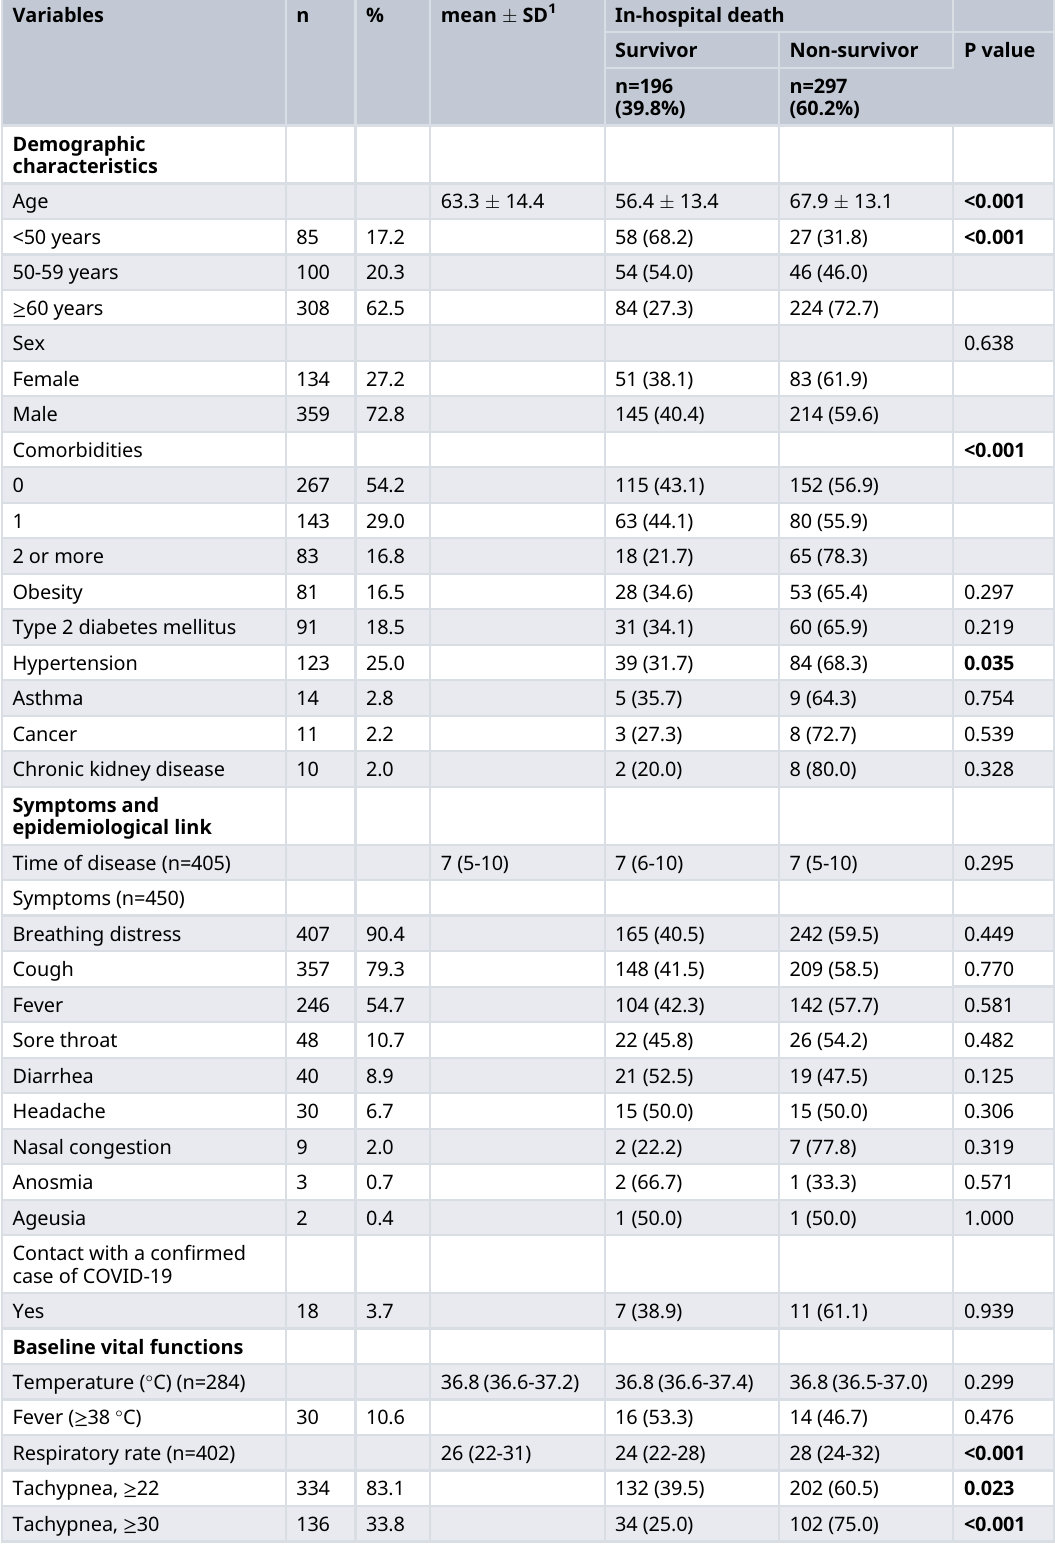
Table 1. Descriptive and bivariate analysis according to in-hospital death in the study